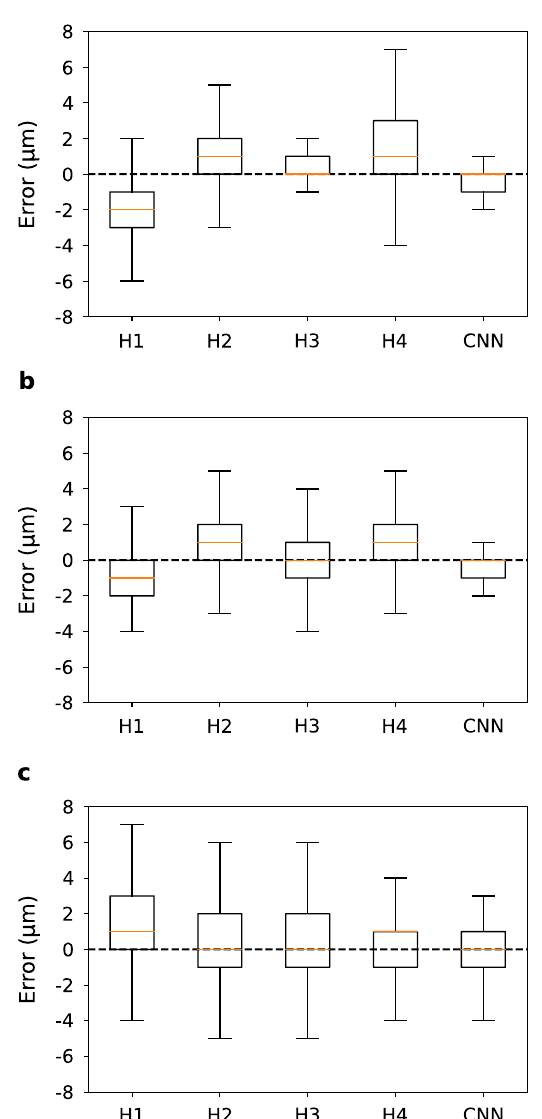
Figure 5. Comparison of the accuracy of the CNN and human annotators. ( a ) Error of human annotators (H1–H4) compared with the CNN in determining the in-focus image given a full z-stack to analyze, relative to a reference annotation. ( b ) Error of human annotators in re-determining the in-focus image relative to their previous annotation. ( c ) Error in determining the numerical z-position of an image without using any additional